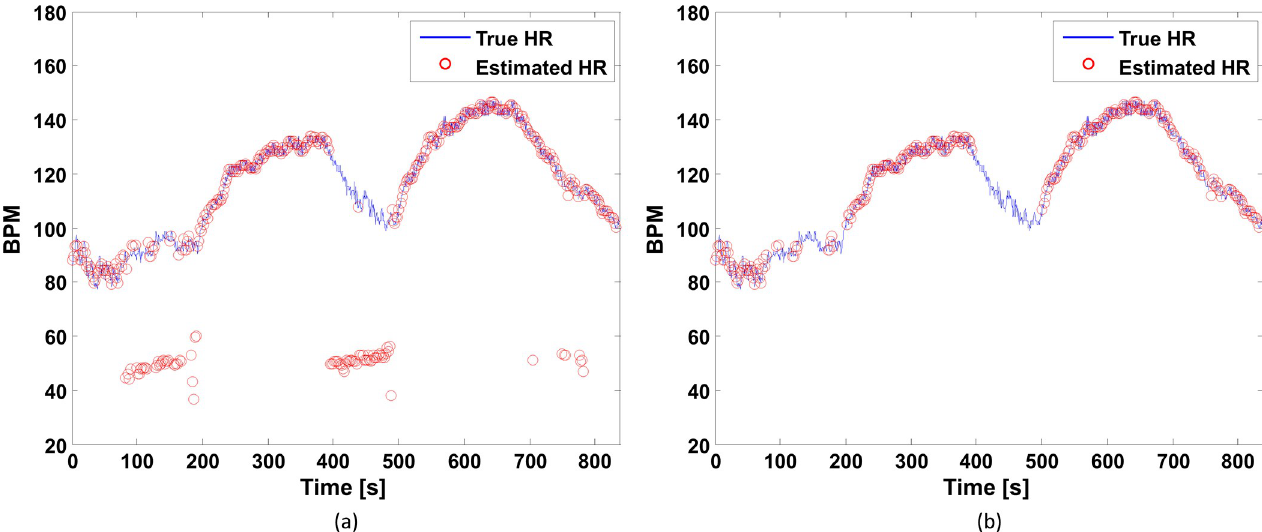
Fig 3. Comparison of HR estimation results. (a) with and (b) without the FSM framework for subject 1 in the BAMI dataset.